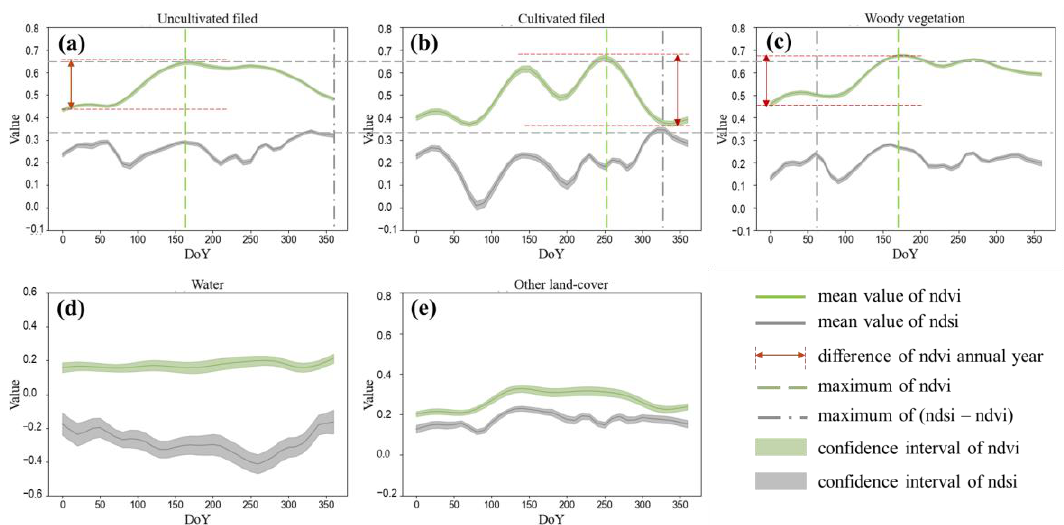
Figure 6. Spectral indices (NDVI and NDSI) temporal profiles for “Uncultivated field” ( a ), “Cultivated field” ( b ), “Woody vegetation” ( c ), “Water” ( d ) and “Other land cover” ( e ). To improve land cover classification, blue, green, red, near-infrared (NIR), and shortwave-infrared (SWIR) bands were used. Figure 7a – c show that the blue, green, and red bands can distinguish “Uncultivated field” from “Water” and “Other land cover”. The NIR band is also important for detecting vegetation changes [46 – 48]; Figure 7d shows that it could distinguish “Uncultivated field” from all other types of land cover except “ Woody vegetation”. Meanwhile, SWIR differentiated “Uncultivated field” from “Water” and